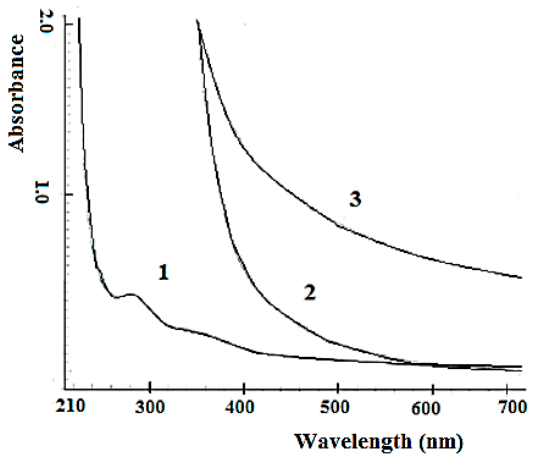
Figure 1. UV–Vis absorption spectra of pectin solution 0.5% (1), chitosan hydrochloride solution 2.0% (2), mixed solution of pectin and chitosan hydrochloride at the molar ratio 1:1 (3).